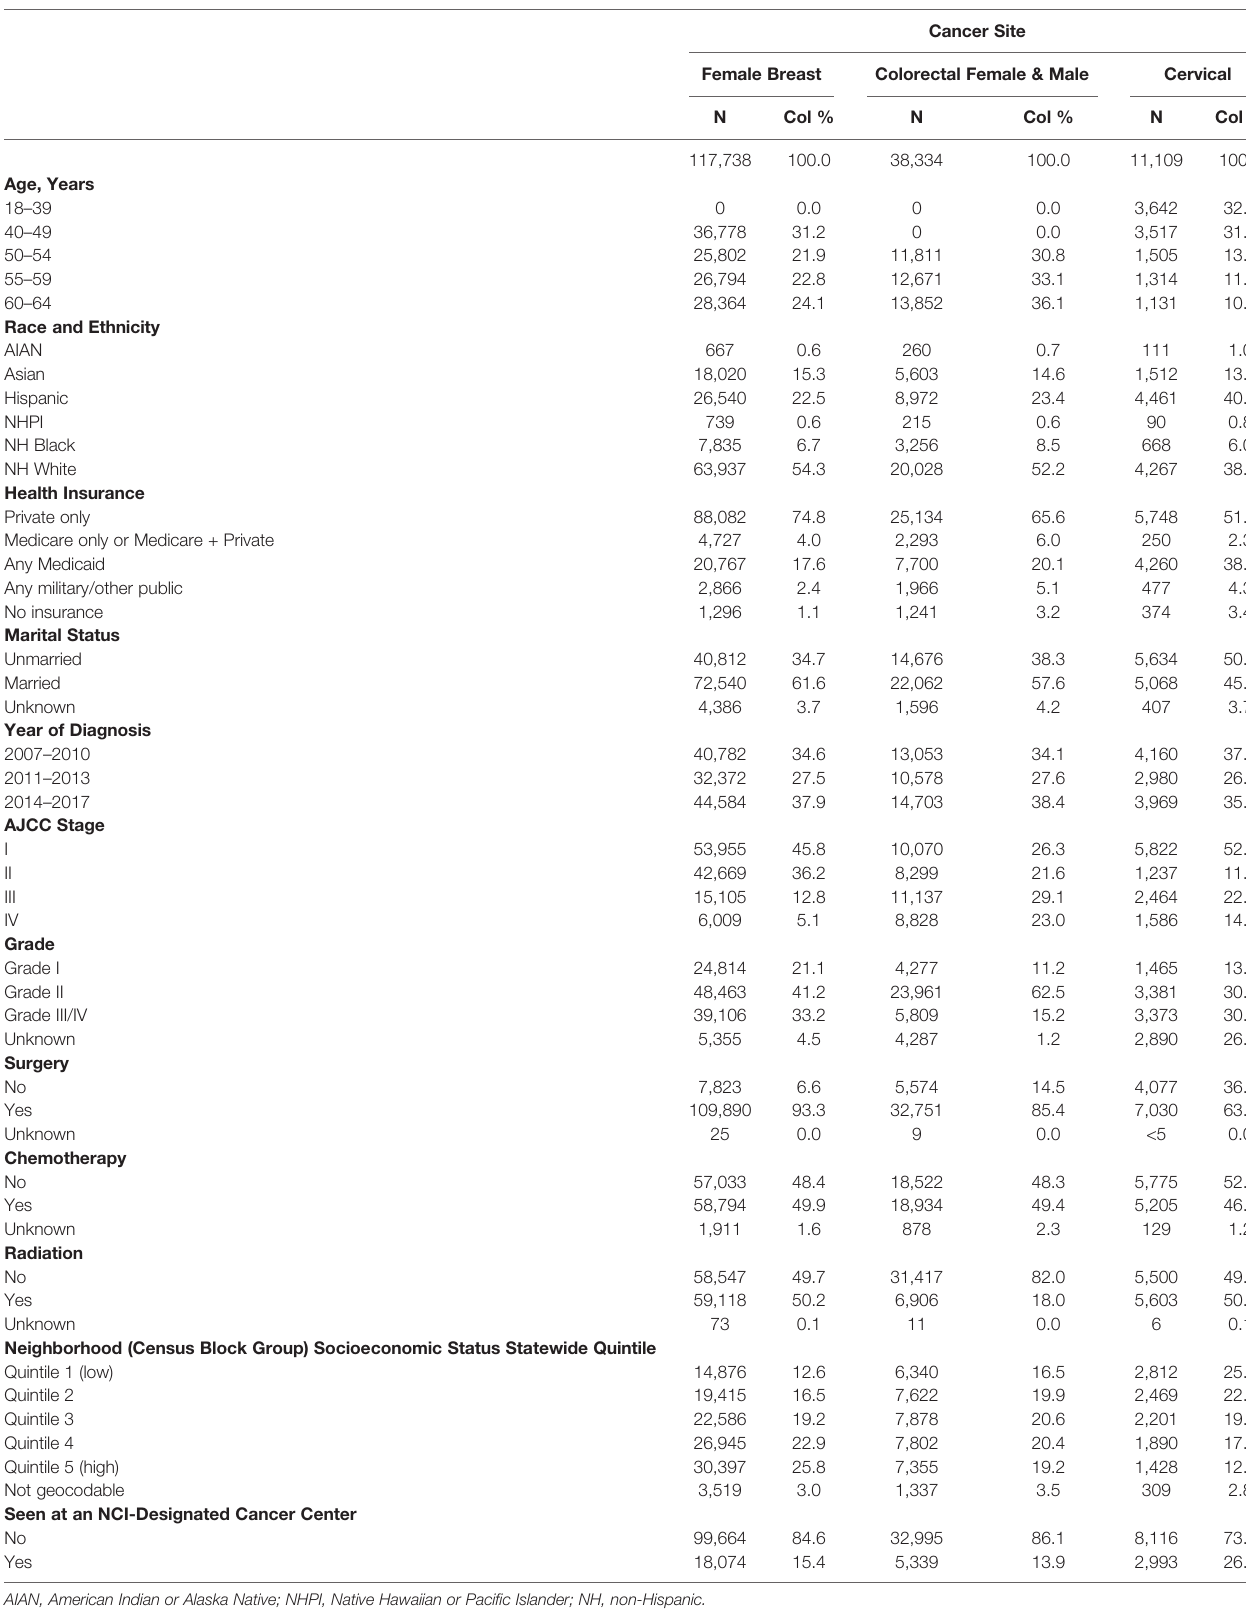
TABLE 1 | Characteristics by Cancer Site in Patients Under 65 Years of Age, California, 2007 –